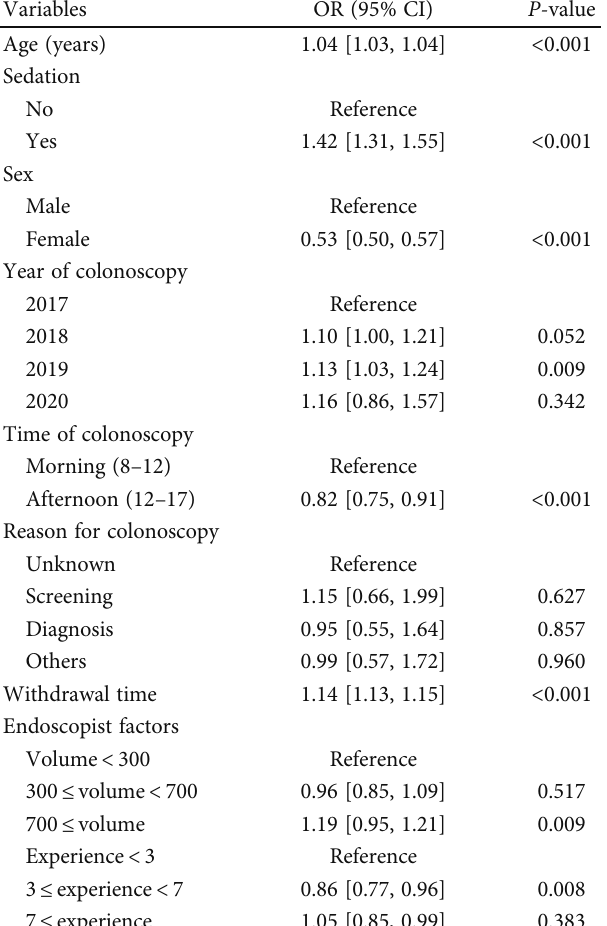
Table 3: Univariate logistic regression analysis of risk factors for adenoma detection